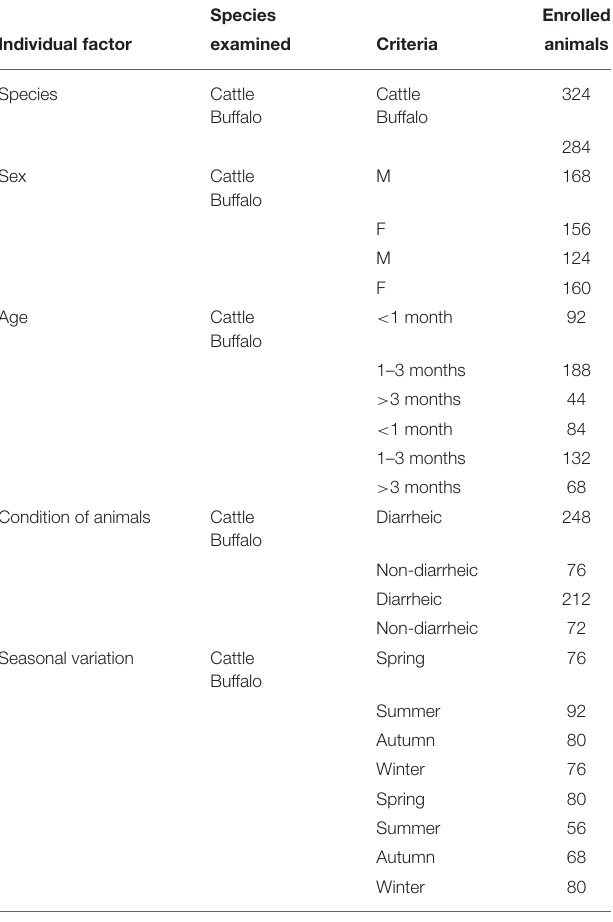
TABLE 1 | The full details of the study cohort for each of the enrolled animal species, sex, age, condition of animals, and seasonal variation.